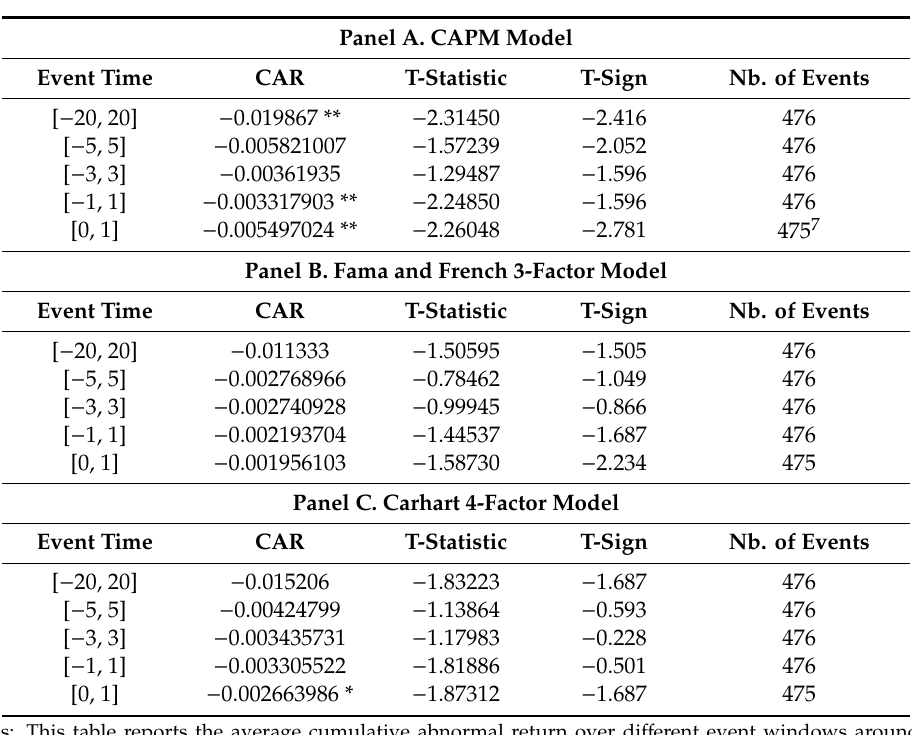
Table 3. Stock market reaction to green bond issuance